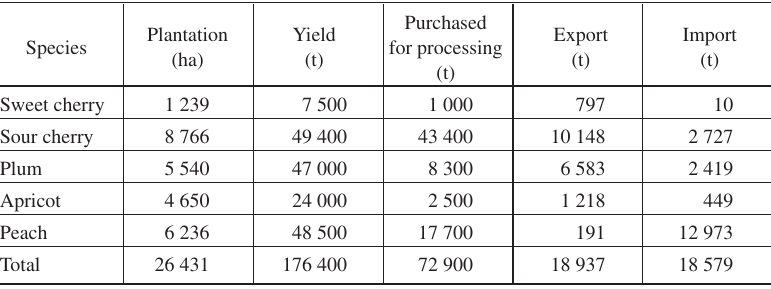
Table 3. Yields and trade of stone fruits (2007)